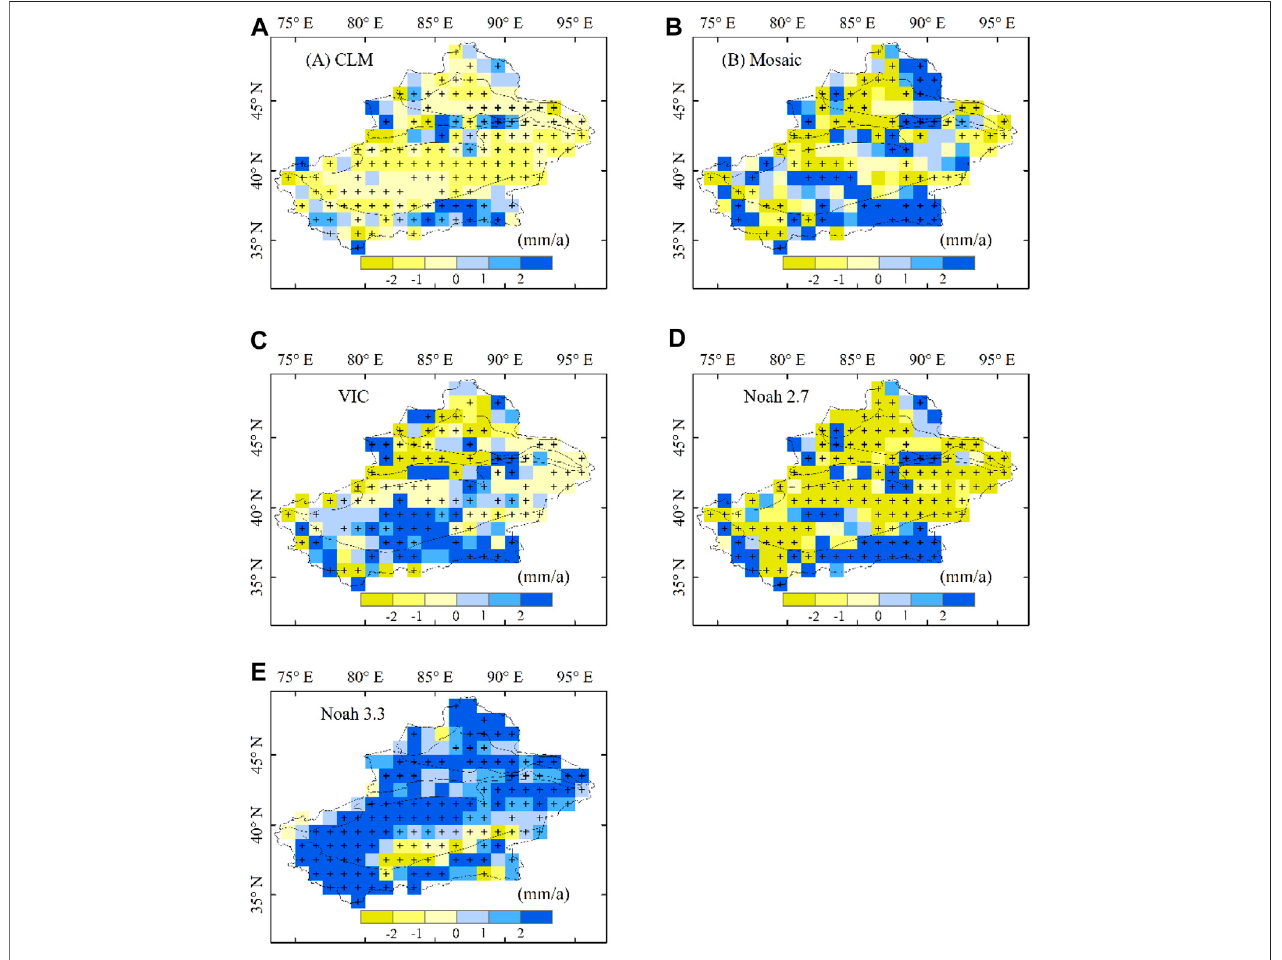
FIGURE 6 | Same as Figure 4 , but for MAM soil